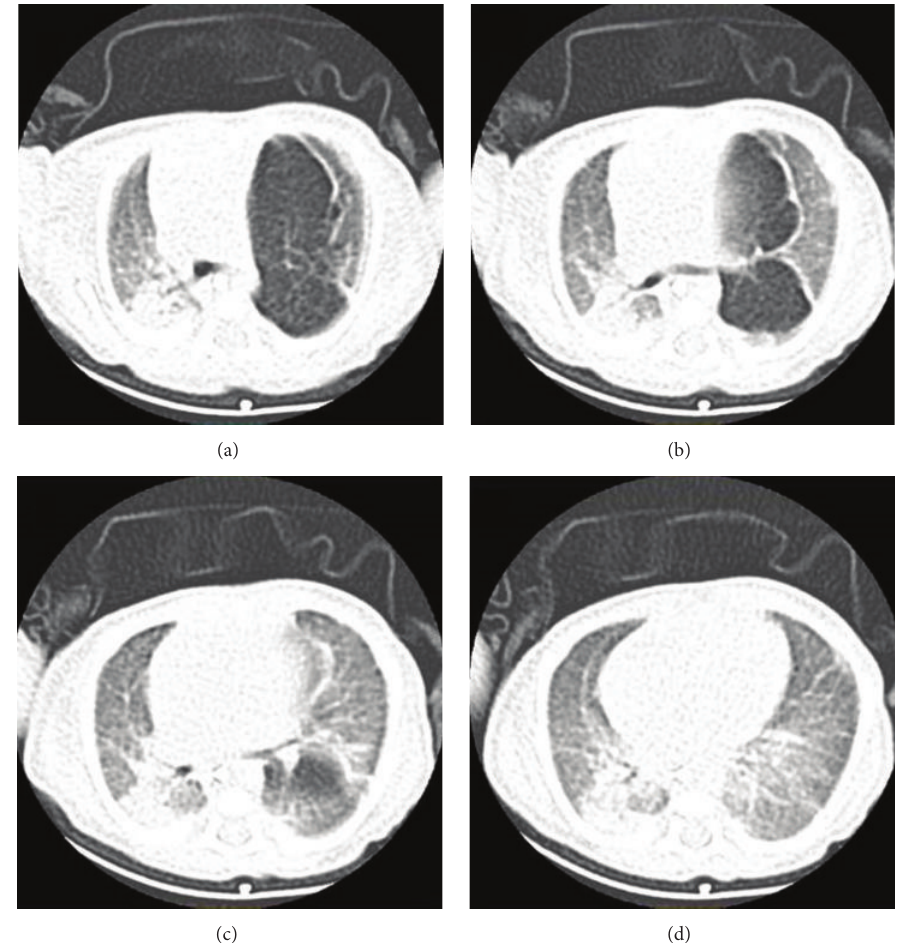
Figure 1: Computed tomography of the chest showing the presence of an emphysematous left upper lobe and atelectasis of the left lower lobe with subsequent contralateral mediastinal shift to the right causing atelectasis of the right